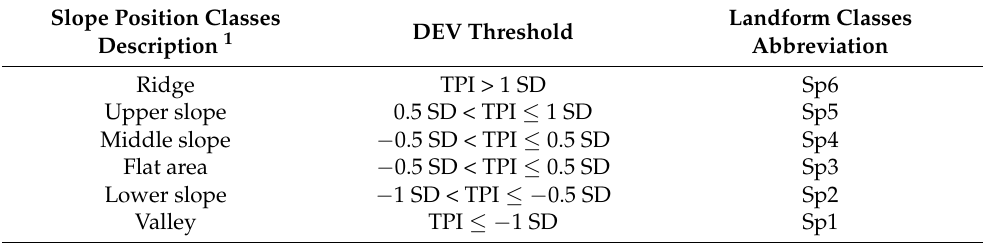
Table 1. Description and abbreviation of slope position classes used for habitation practices’ charac- terization during the LBA in the Jijia catchment, obtained based on TPI-based DEV calculated for various neighborhood sizes and terrain slope (first method).